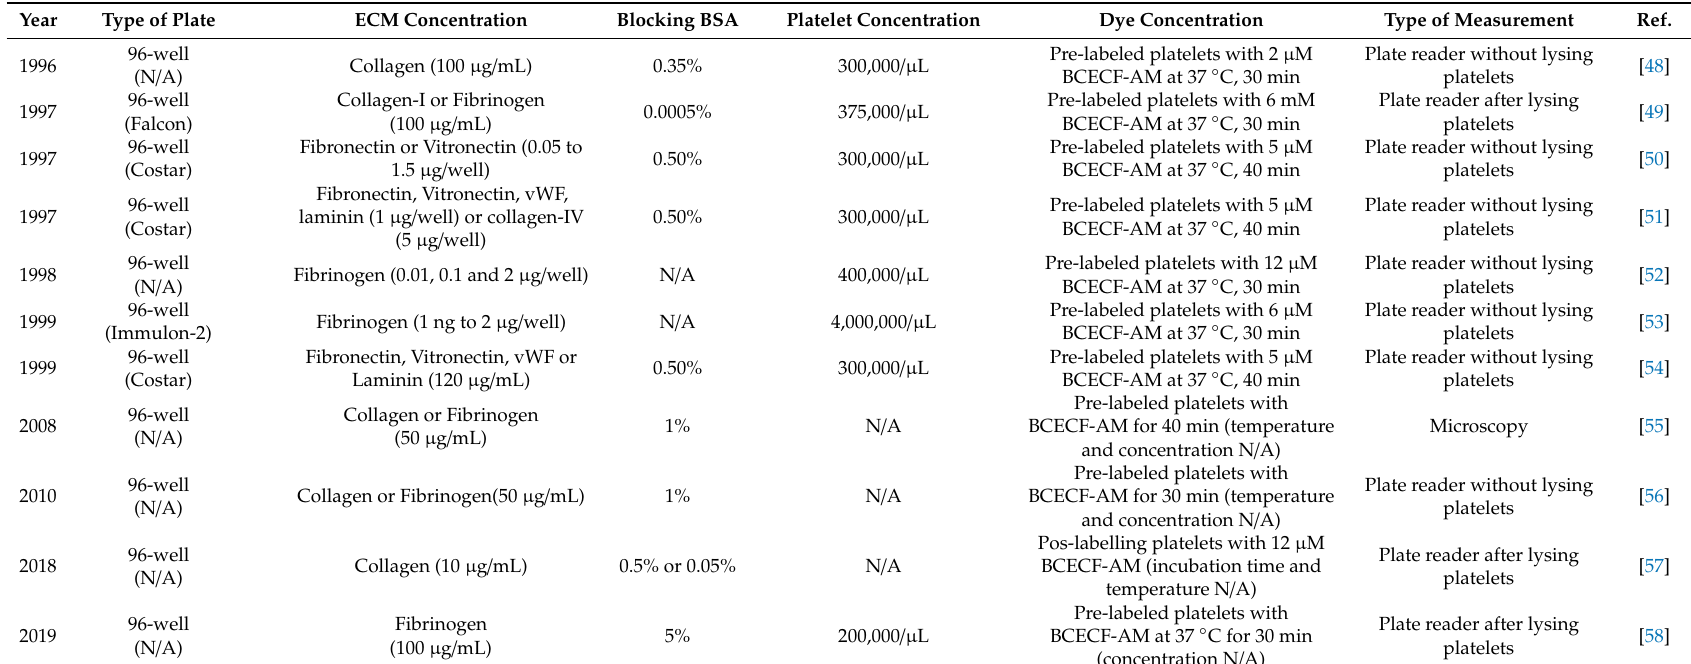
Table 2. Previous studies using BCECF-AM to measure platelet